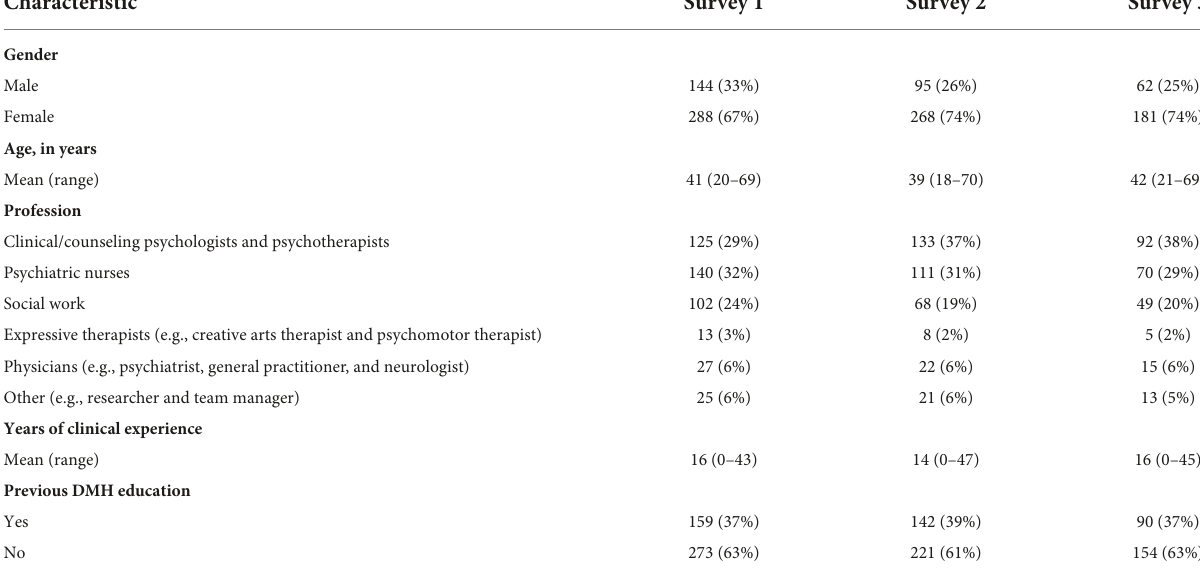
TABLE 1 Demographic data for the first ( n = 432), second ( n = 363), and third ( n = 244) survey, including gender, age, and profession. Characteristic Survey 1 Survey 2 Survey